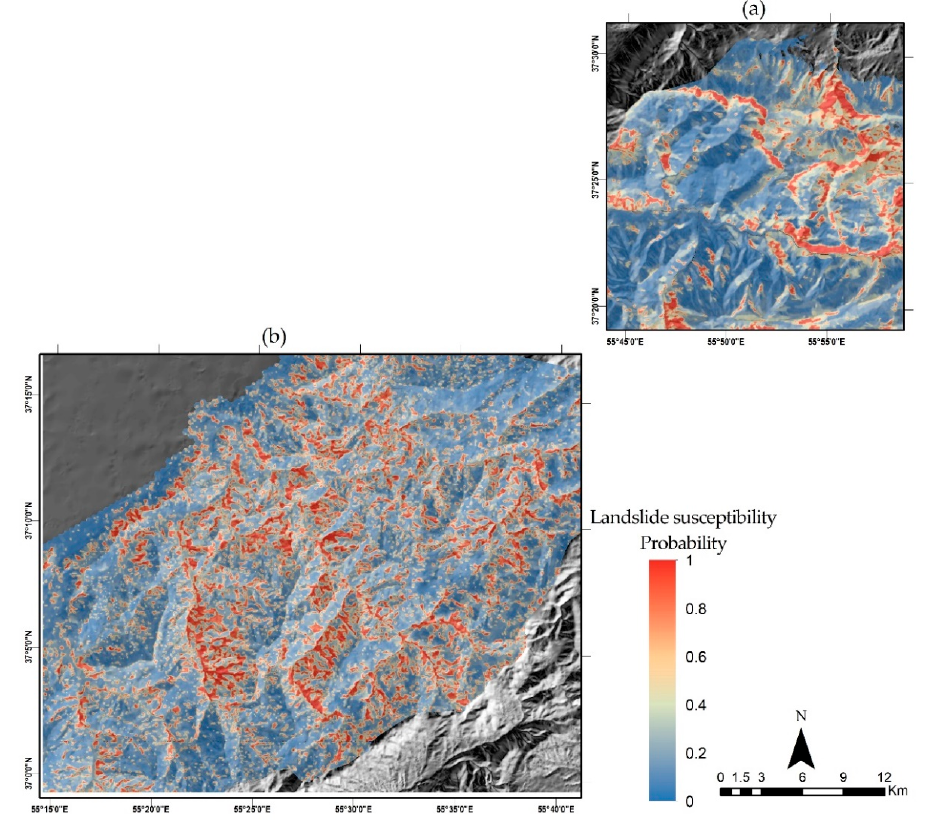
Figure 5. The landslide susceptibility maps of the protected forest ( a ) and the non-protected forest ( b ) in NE Iran. The maps show that the majority of high susceptibility values of landslide were